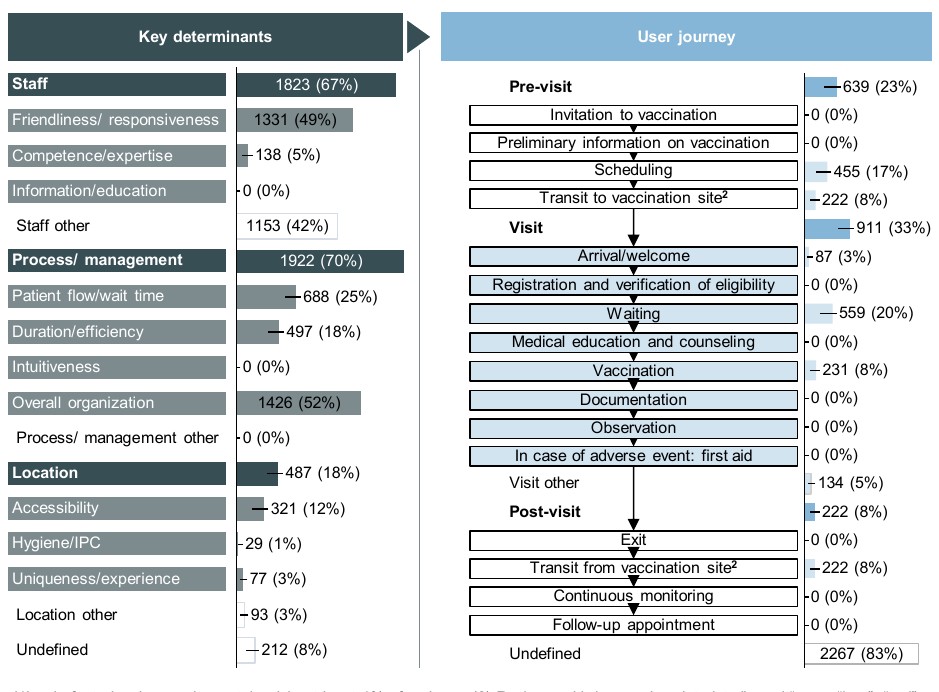
Figure 5. Keywords featured in at least 1% of reviews sorted to the user experience framework. Keywords identified through the keyword extraction were grouped and then mapped against the framework to highlight key interactions and identify recurring themes across reviews. A single review could contain keywords related to several dimensions or phases, e.g., both “organization” and “staff”. A single keyword may also simultaneously be related to an enabler and the journey, e.g., “wait”, which is related to “waiting” in the journey and to “patient flow/wait time” under enabler dimensions. The frequency count of the enabler dimensions or journey phases hence do not add up to the total number of reviews.